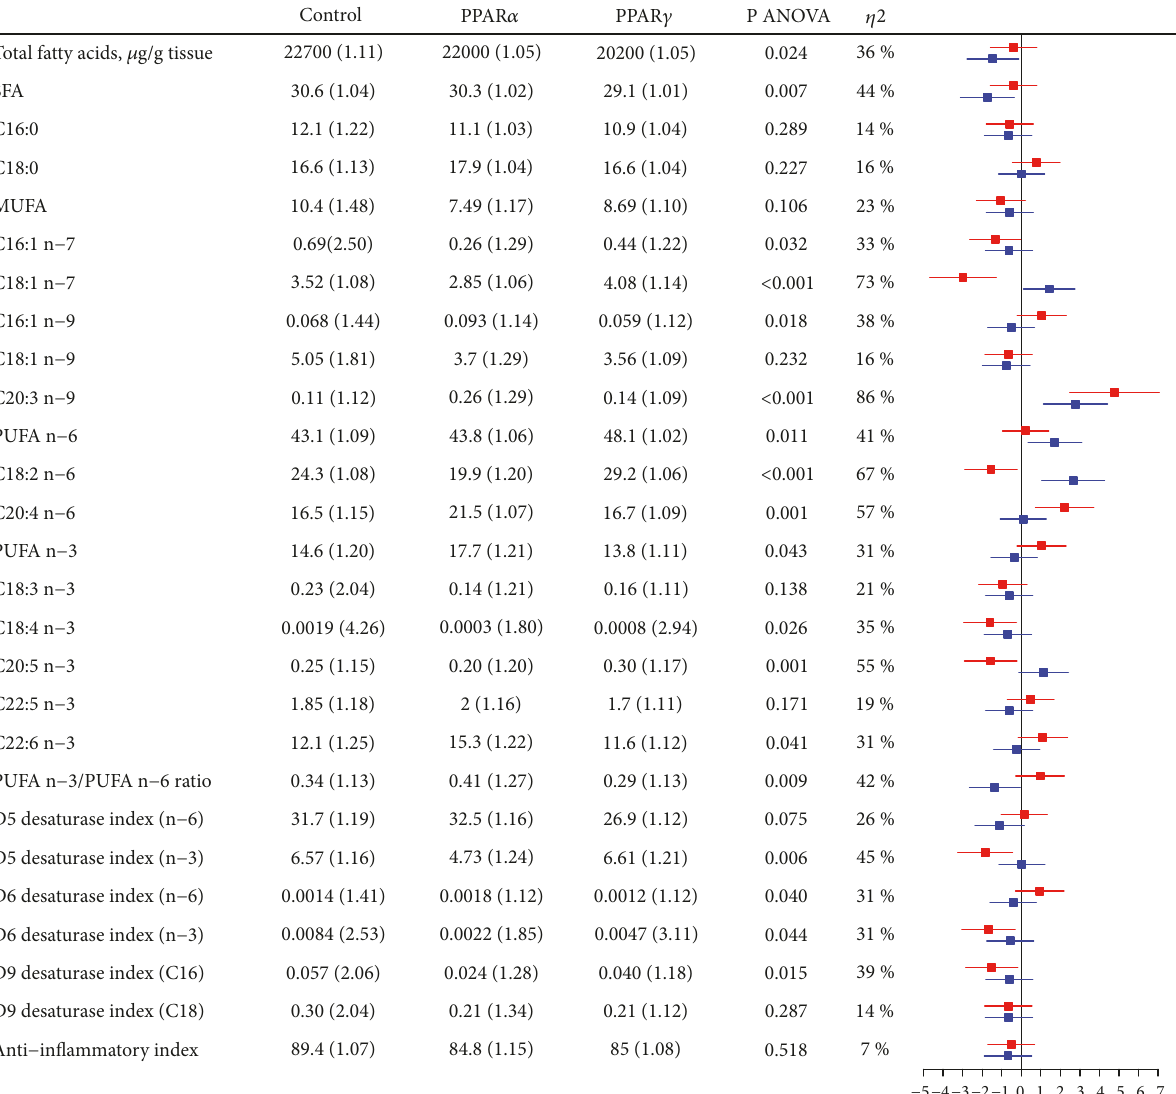
Figure 3: Cardiac fatty acid composition (wt%) in Wistar rats after treatment with PPAR agonists for 12 days. Values are geometric mean (gSD). Red bars correspond to PPAR 𝛼 vs control and blue bars to PPAR 𝛾 vs control. ANOVA, analysis of variance; MUFA, monounsaturated fatty acids; PPAR, peroxisome proliferator-activated receptor; PUFA, polyunsaturated fatty acids; SFA, saturated fatty acids. D5 desaturase index (n-6) = C20:4n-6 / C20:3n-6 (an indirect index of Δ 5 desaturase activity based on n-6 PUFA). D5 desaturase index (n-3) = C20:5n-3 / C20:4n-3 (an indirect index of Δ 5 desaturase activity based on n-3 PUFA). D6 desaturase index (n-6) = C18:3n-6 / C18:2n-6 (an indirect index of Δ 6 desaturase activity based on n-6 PUFA). D6 desaturase index (n-3) = C18:4n-3 / C18:3n-3 (an indirect index of Δ 6 desaturase activity based on n-3 PUFA). D9 desaturase index (C16) = C16:1n-7 / C16:0 (an indirect index of Δ 9 desaturase activity based on C16 SFA/MUFA). D9 desaturase index (C18) = C18:1n-9 / C18:0 (an indirect index of Δ 9 desaturase activity based on C18 SFA/MUFA). Anti-inflammatory index